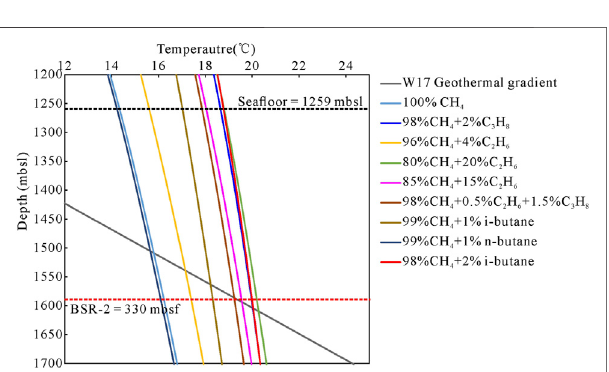
FIGURE8| ThethicknessoftheGHSZwithdifferentgascomponentsat site W17.